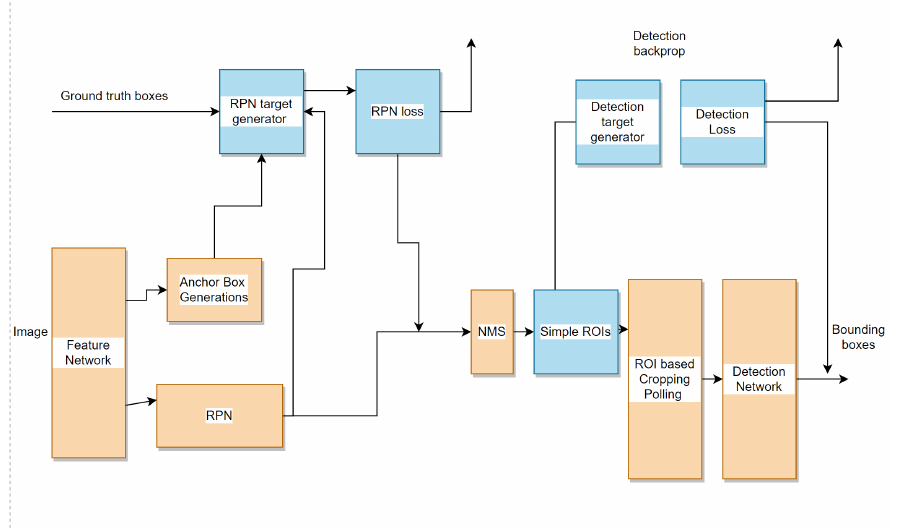
Figure 8. The architecture of Faster